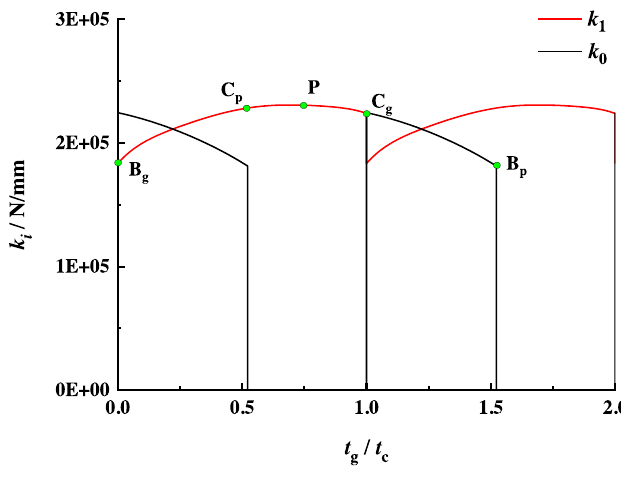
Fig. 2. Mesh stiffness of tooth pairs.